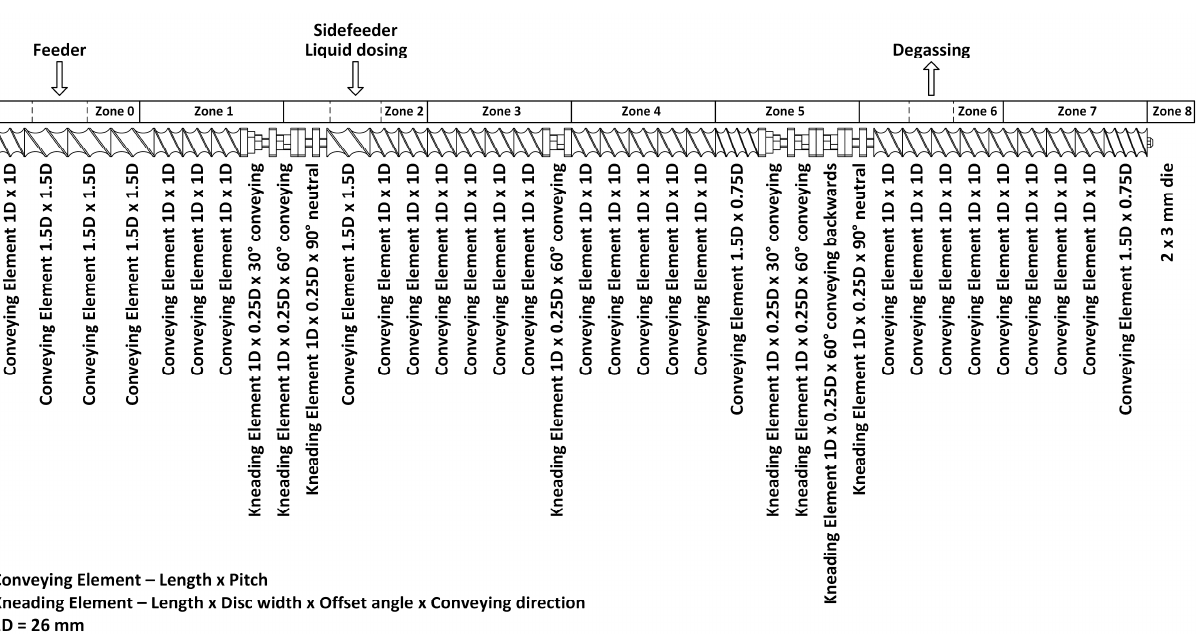
Figure 1. Screw design for compounding plasticized cellulose acetate